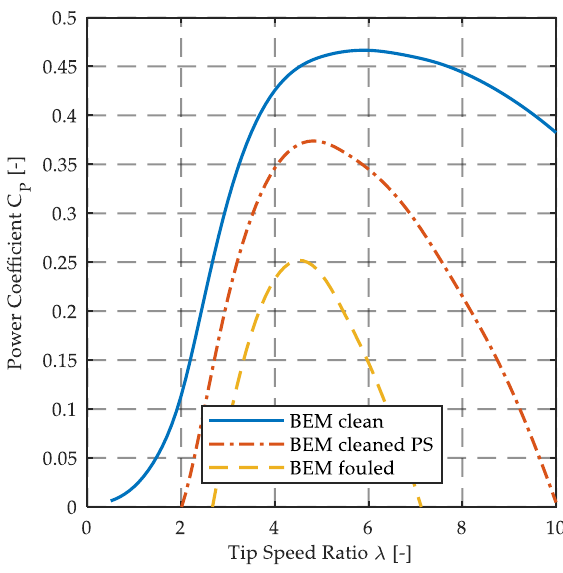
Fig. 11 Power coefficient as function of the tip speed ratio (BEM prediction of the different blade conditions)